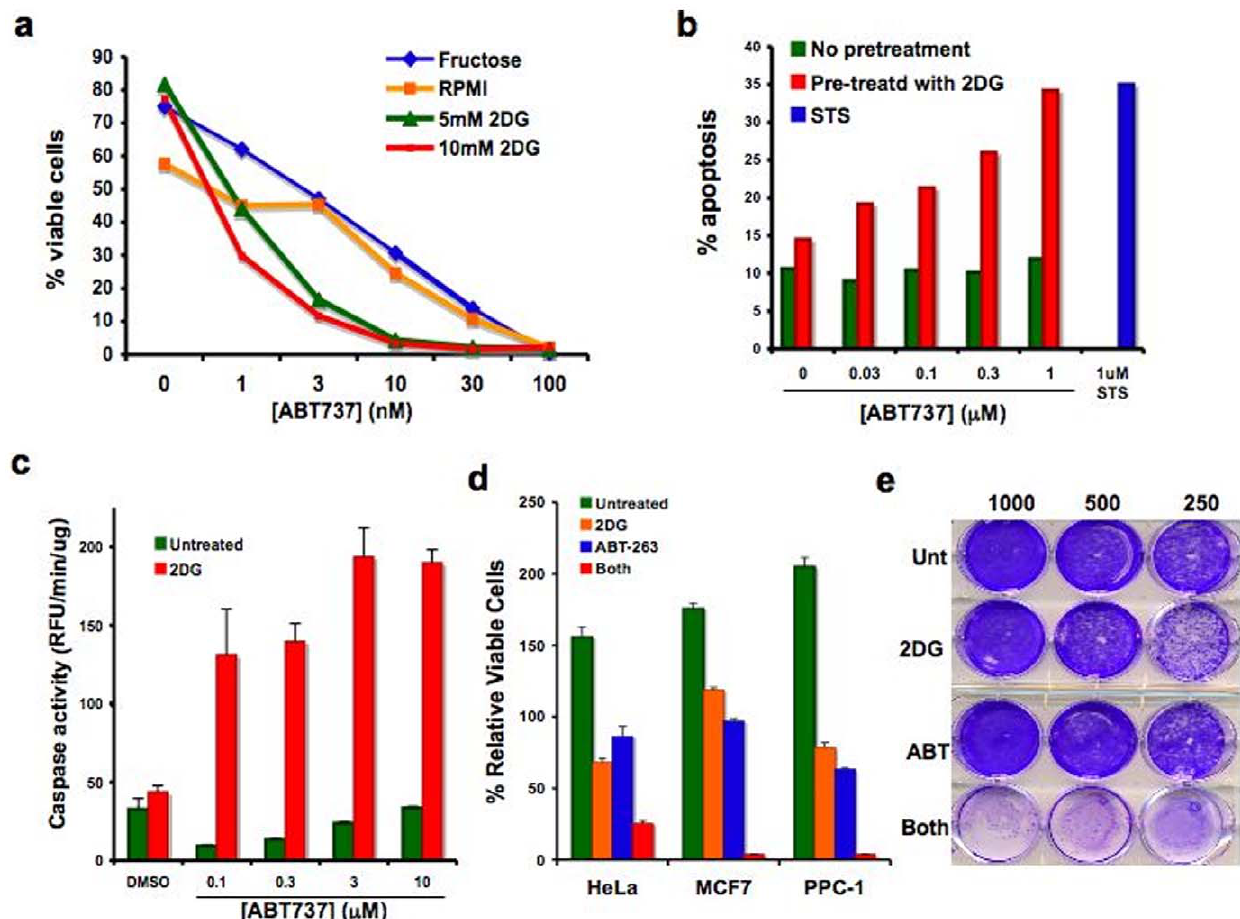
Figure 1. Annexin V-staining of 2DG-ABT treated RS(4;11) and HeLa cells. a, RS(4;11) cells pre-treated with 20 mM fructose or 0–10 mM 2- deoxy-D-glucose in regular RPMI medium containing 12 mM glucose, for 1 hour before the addition of ABT-737 at indicated concentrations. 9 hours later, cells were analyzed by FACS for Annexin-V positivity. Chi Square Test of Independence for two variables, 2DG and ABT, was P(x ˜ 12 . 193.35)=0.000000. Since the combination was clearly better than expected values, the statistic suggests synergistic interaction between 2DG and ABT-737. b, HeLa cells were pre-treated for 1 hour either with or without 10 mM deoxyglucose in DMEM containing 12 mM glucose, before adding ABT-737. Six hours later, cells were analyzed by FACS for Annexin-V staining. c, HeLa cells were pre-treated for 3 hours with 2DG before